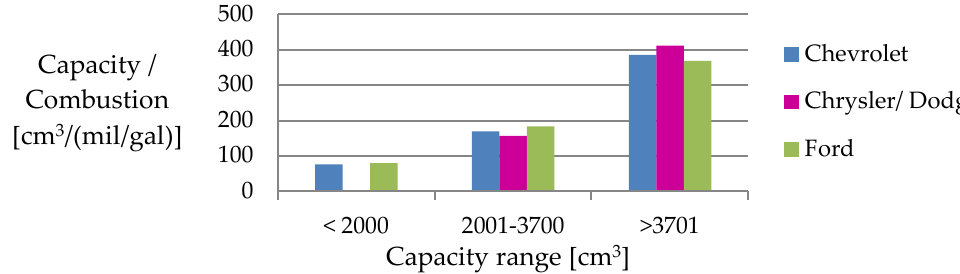
American car brands. Source: Developed own. Figure 15. Ratio of engine capacity to power in individual engine capacity compartments among